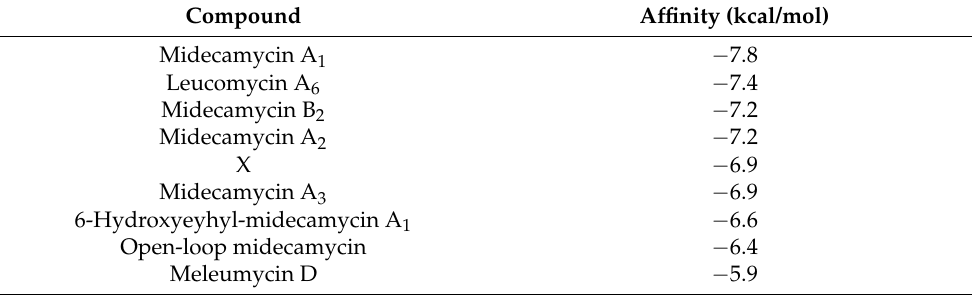
Table 6. Docking